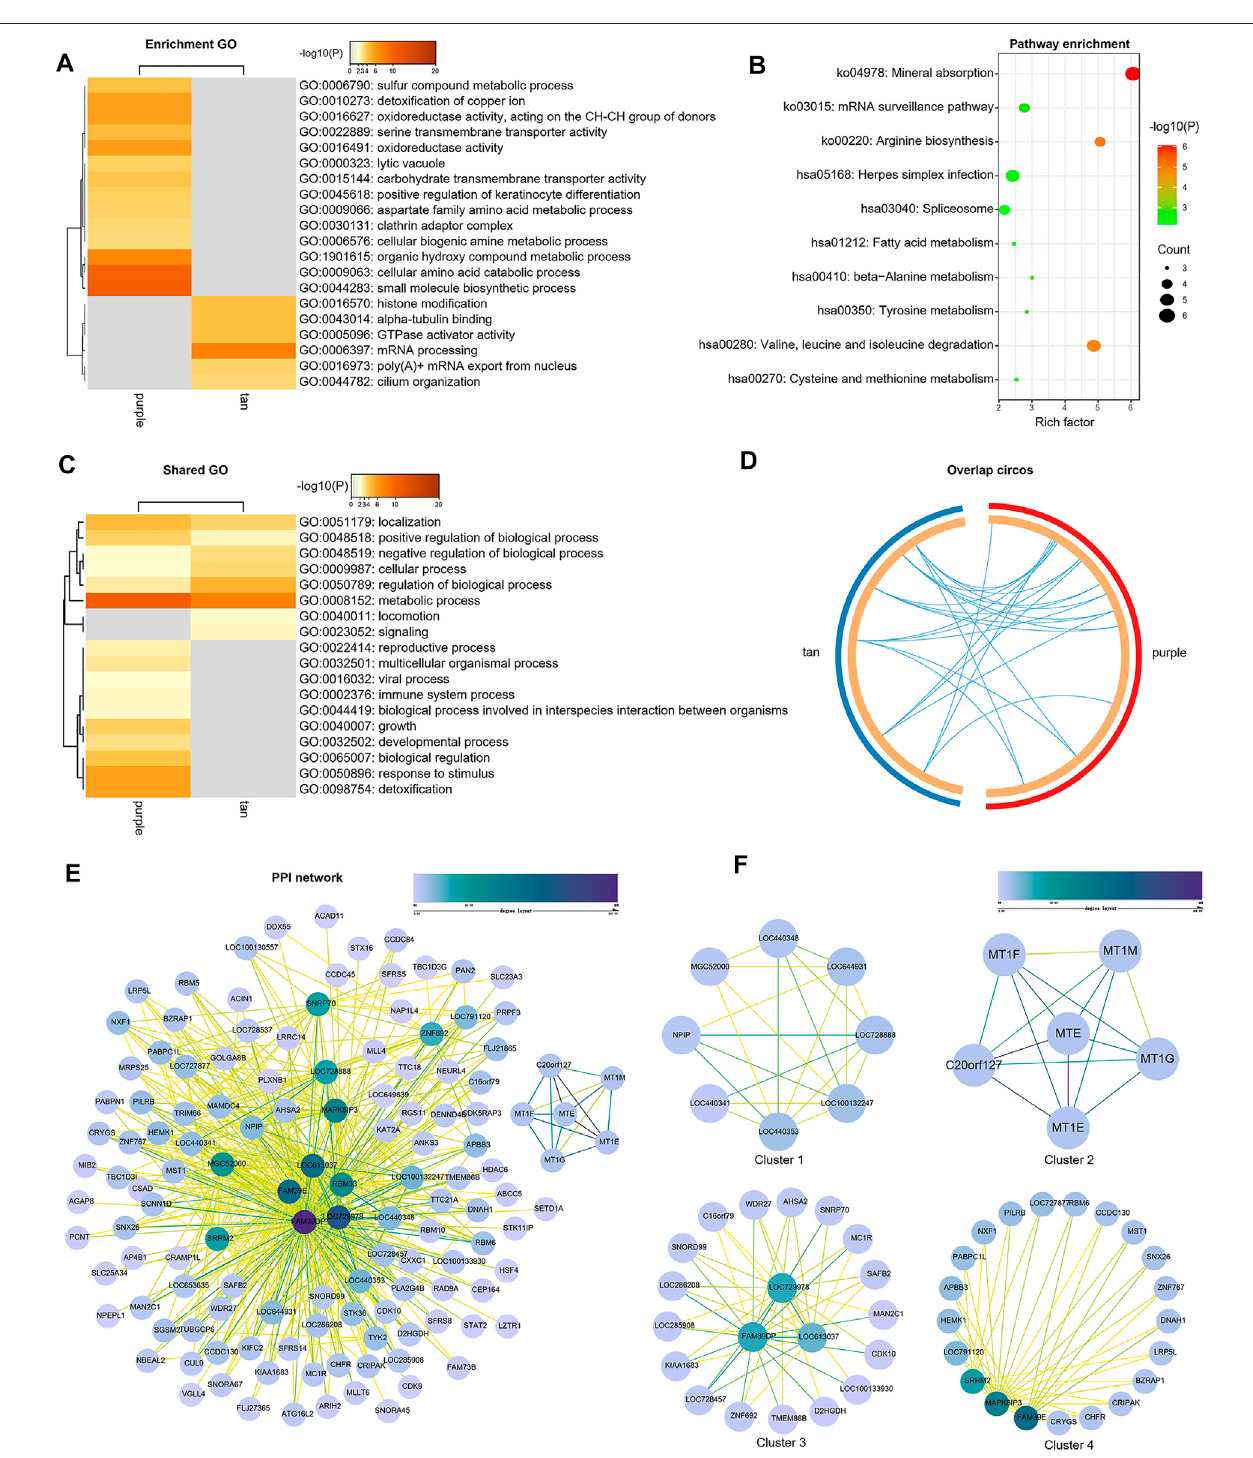
FIGURE 7 | Functional enrichment analysis and construction of PPI network in the tan and purple modules. (A) GO terms of CRPC-related genes. (B) KEGG pathways of CRPC-related genes. (C) GO terms shared by both tan and purple modules. (D) Genes in different modules are shared by the same GO terms. (E) PPI network of all proteins in the tan and purple modules. (F) Functional modules in the whole PPI network.